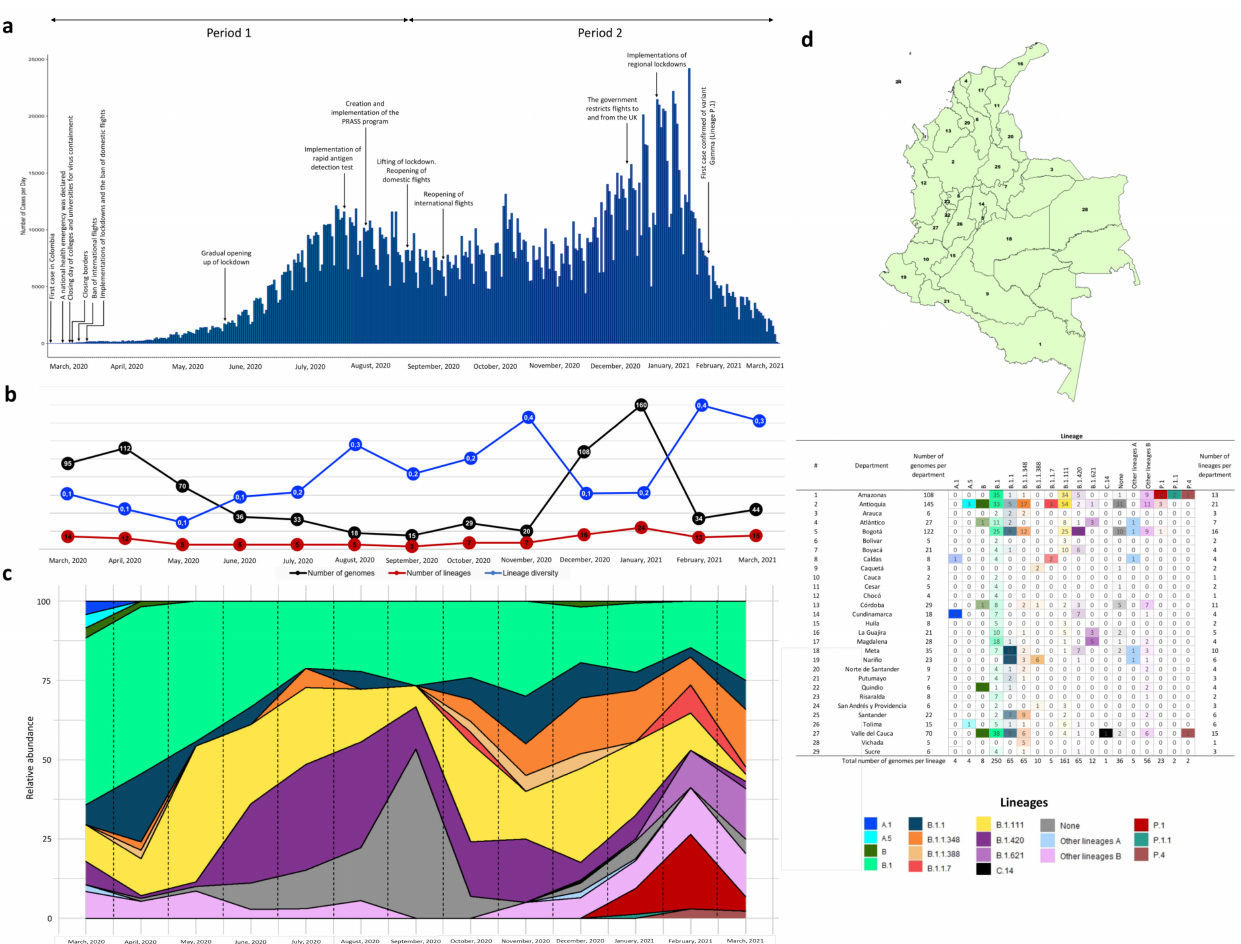
Figure 1. Time series of cases and genomic surveillance in Colombia during the first year of the COVID-19 pandemic (since 6 March 2020 to 6 March 2021). ( a ) Number of cases reported through time. This graph refers to 2,273,245 cases based on the notification date. Two time periods are shown in relation to the dynamics of the cases and the behavior of the control measures taken by the national government. The first period was from 6 March to 10 August 2020. The second period was from 11 August 2020 to 6 March 2021. The main measures and strategies implemented by the national and local governments are also identified. ( b ) Genomic sampling through time at the national level. Black line corresponds to the total number of genomes sequenced per month, the red line to the total number of lineages identified monthly and the blue line is an index of the estimated lineage diversity calculated in this work using the number of lineages detected with respect to the number of genomes sequenced during the same monthly window; the numbers are included in the circles of the line graphs. ( c ) Relative abundance of the lineages circulating in Colombia through the months. ( d ) Geographical distribution of the lineages identified in Colombia distributed by department. The number included inside of the table indicate the number of genomes identified for each